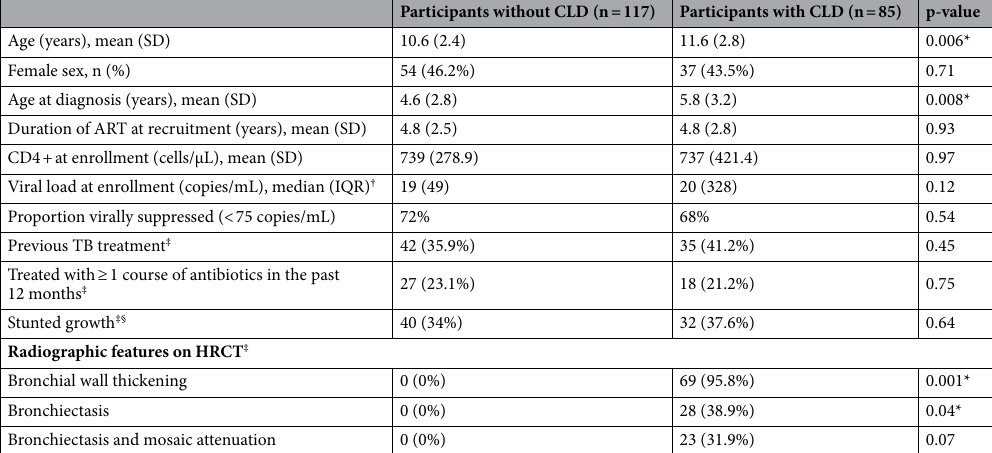
Table 1. Characteristics of study participants. SD standard deviation, CLD chronic lung disease, TB tuberculosis, HRCT high resolution chest computed tomography. *p < 0.05 = significant; † Wilcoxon-rank sum test; ‡ Chi-square test or Fisher’s exact test; § ”Height for age" value ≤ two standard deviations of the WHO Child Growth Standards 45